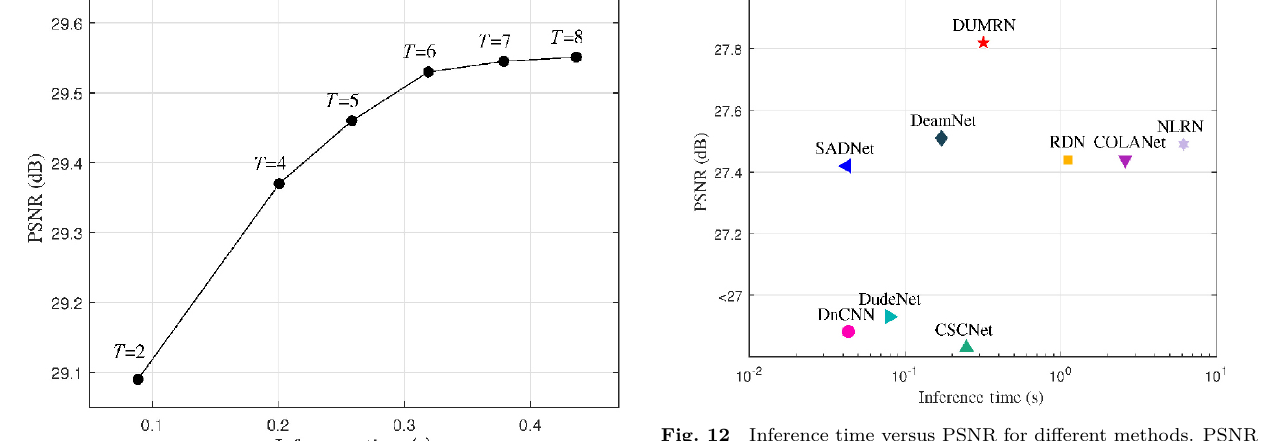
Fig. 12 Inference time versus PSNR for different methods. PSNR (dB) results for gray-scale image denoising were evaluated on the Urban100 dataset with noise level σ = 50.